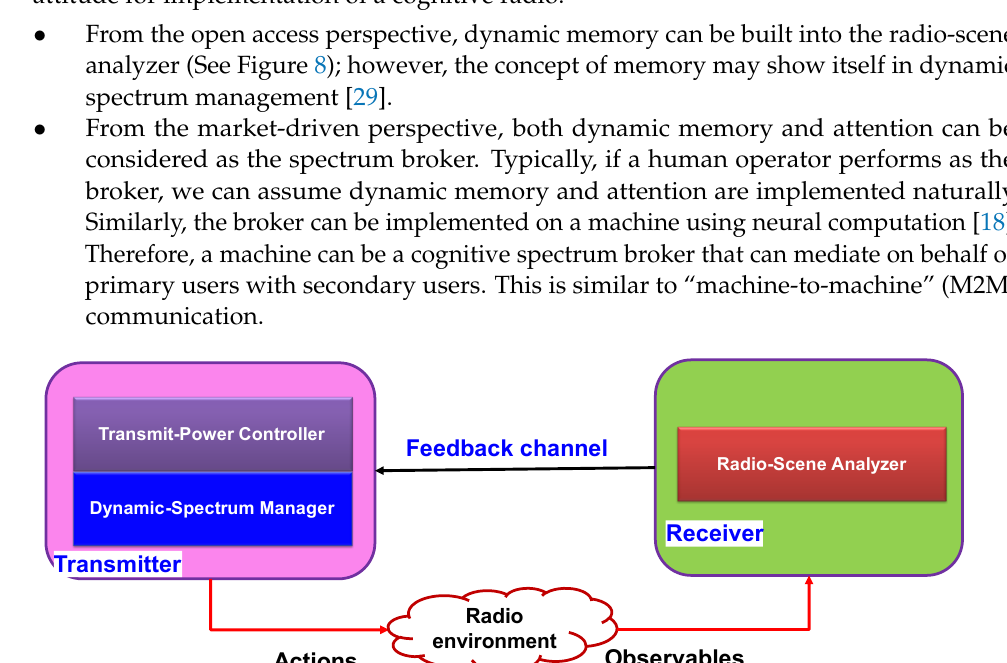
(such as M2M) play a key role in cognitive radio networks. Additionally, when there is an